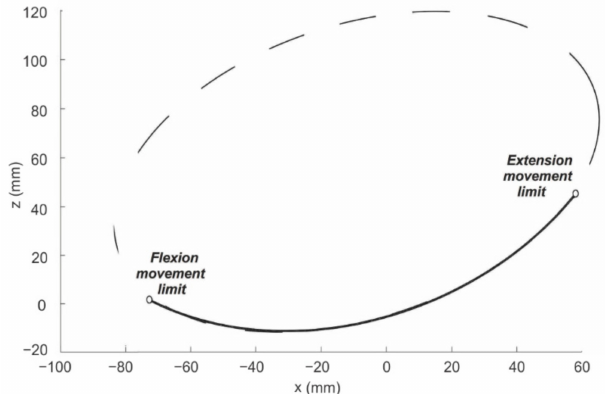
Figure 5. The trajectory of the end-effector prototype.